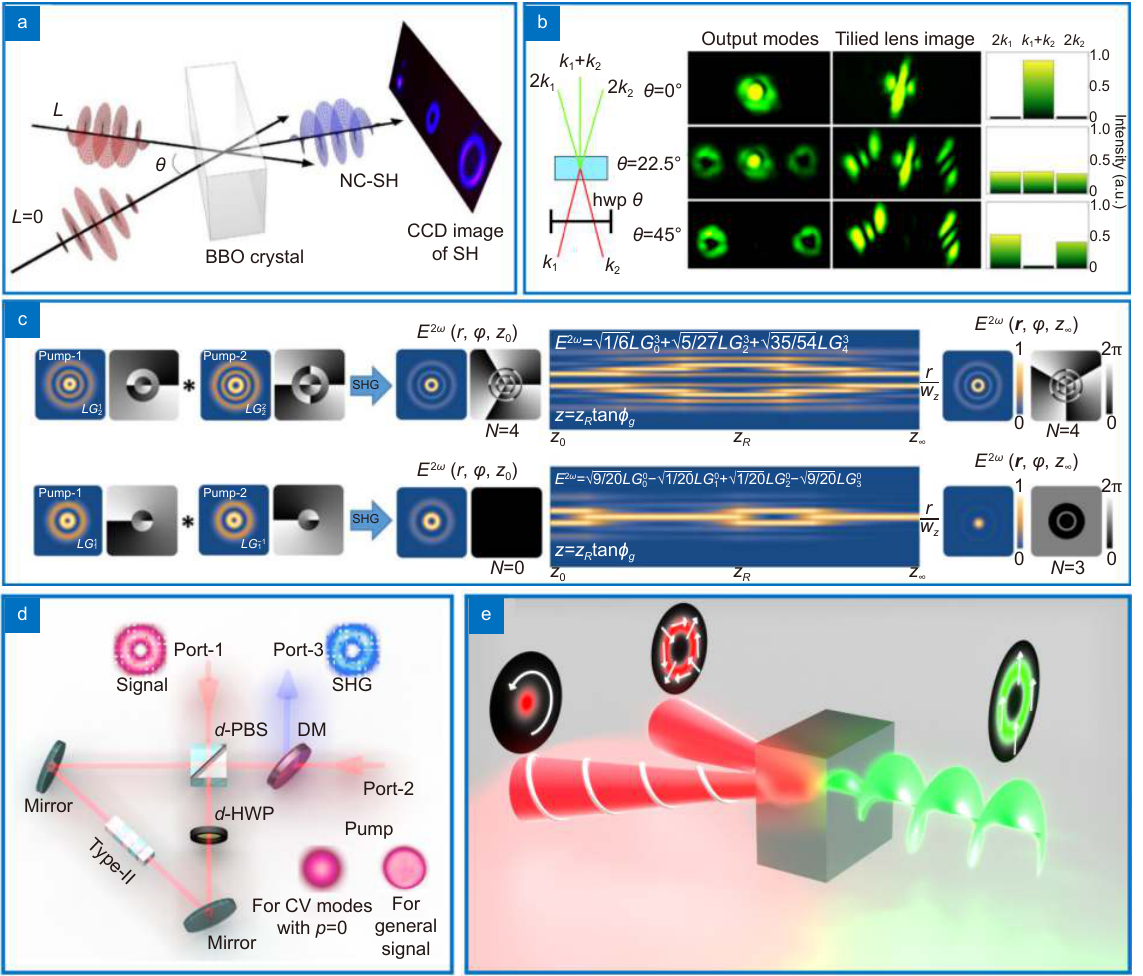
Fig. 2 | Wave mixing with different degrees of freedom. In ( a ), the authors show OAM algebra in noncollinear SHG. When type-II phase- matching is used, the same noncollinear geometry allows for polarization switching, shown in ( b ). This effectively couples multiple degrees of freedom in a single process: path, polarization, radial and angular transverse structures. The radial selection rules of LG modes in wave mixing are demonstrated in ( c ). There is a intrinsic relation between the radial and angular degrees of freedom, which is manifested in the propagation dependence of the spatial profiles. In ( d ), a experimental scheme using a Sagnac interferometer achieves faithful frequency conversion of vector light. Spin and orbital angular momentum are combined in second harmonic generation in ( e ). Figure repoduced with permission from: (a) ref. 48 , Springer Nature; (b) ref. 50 , © Optica Publishing Group; (c) ref. 54 , © American Physical Society; (d) ref. 69 , American Physical Society; (e) ref. 70 ,